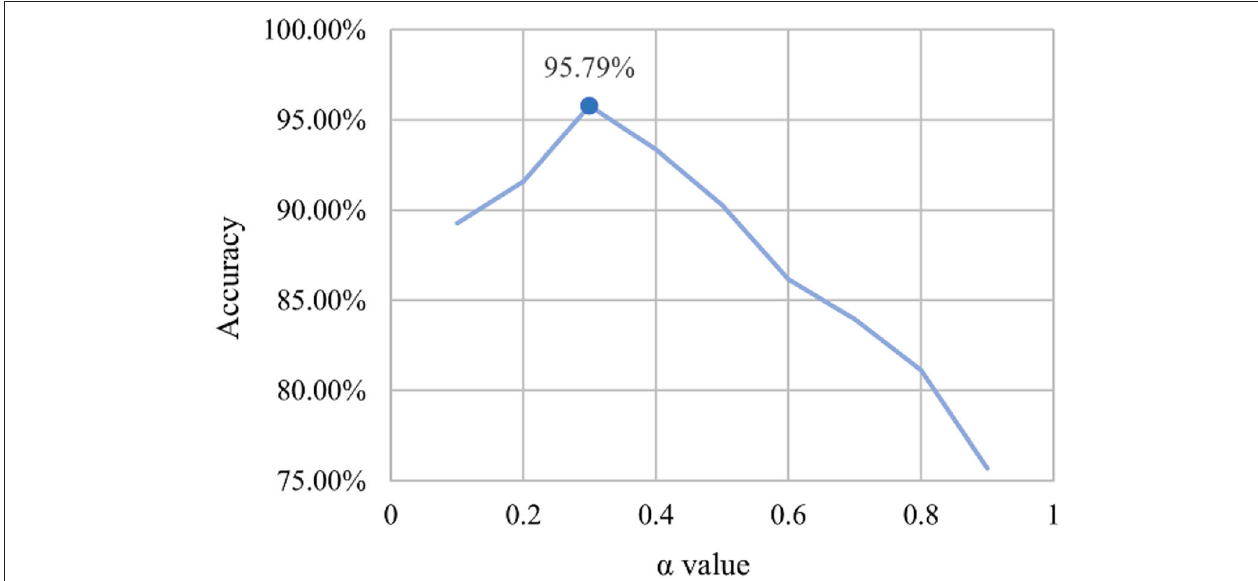
FIGURE 9 | Corresponding relationship between α value and